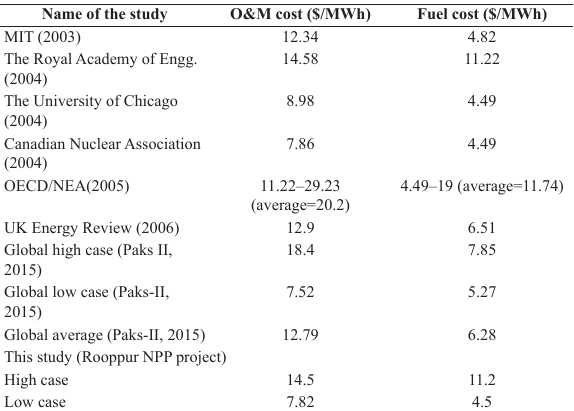
Table 2. NPP O&M costs and fuel costs data (Thomas et al. 2007, Locatelli and Mancini